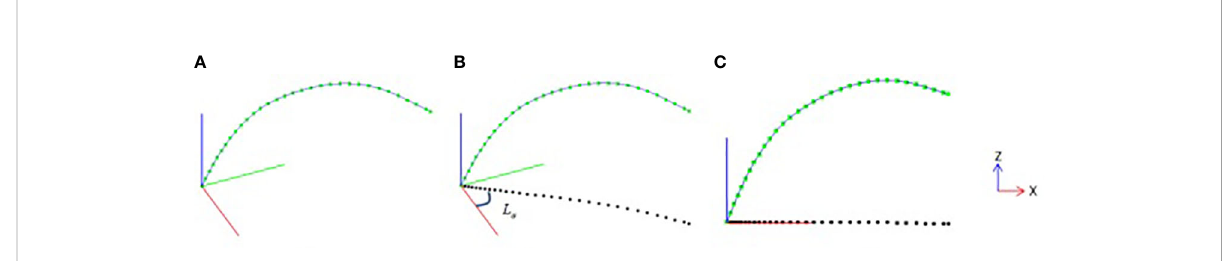
FIGURE 3 Leaf midrib direction plane normalization, (A) leaf midrib curve after smooth correction, (B) projection point of leaf midrib curve on XOY plane, (C) leaf midrib curve after normalization of direction